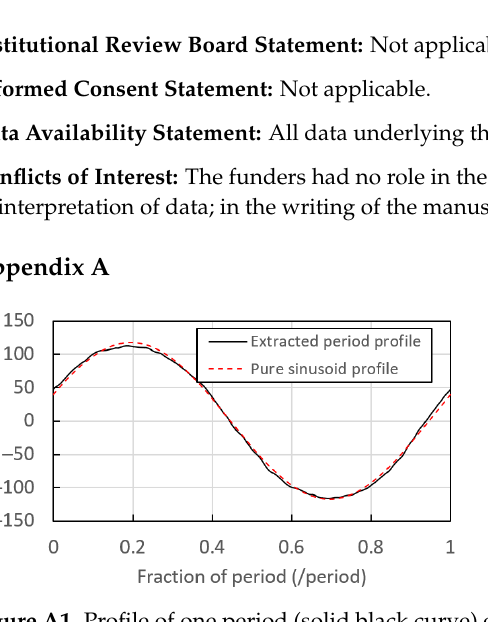
Figure A1. Profile of one period (solid black curve) extracted from the AFM scan within the yellow box in Figure 1d, compared with a pure sinusoid (dashed red curve).